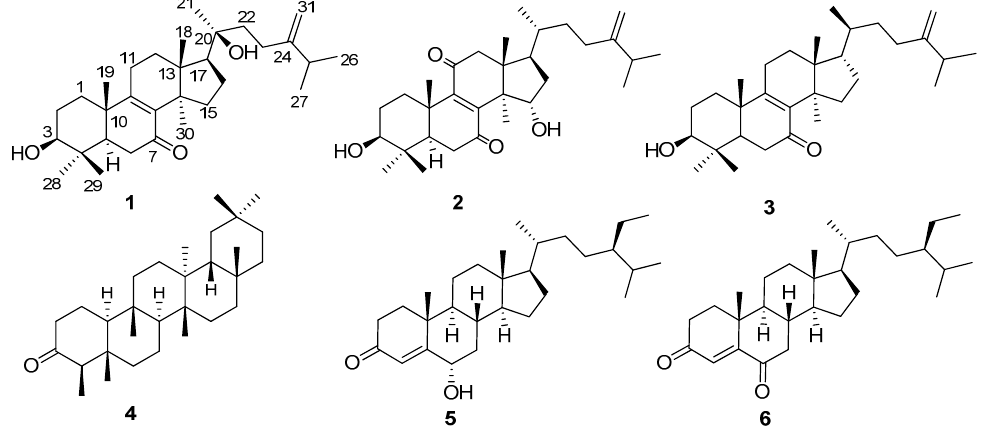
Figure 1. Structures of compounds 1 – 6 .